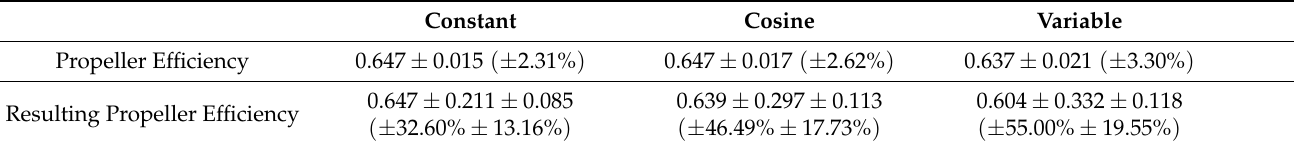
Table 2. Propeller efficiency, resulting propeller efficiency and their uncertainty for each pitch trajectory used in the CFD simulations of the CVP propeller. The percentage number in parenthesis is the relative uncertainty. Constant Cosine Variable Propeller Efficiency Resulting Propeller